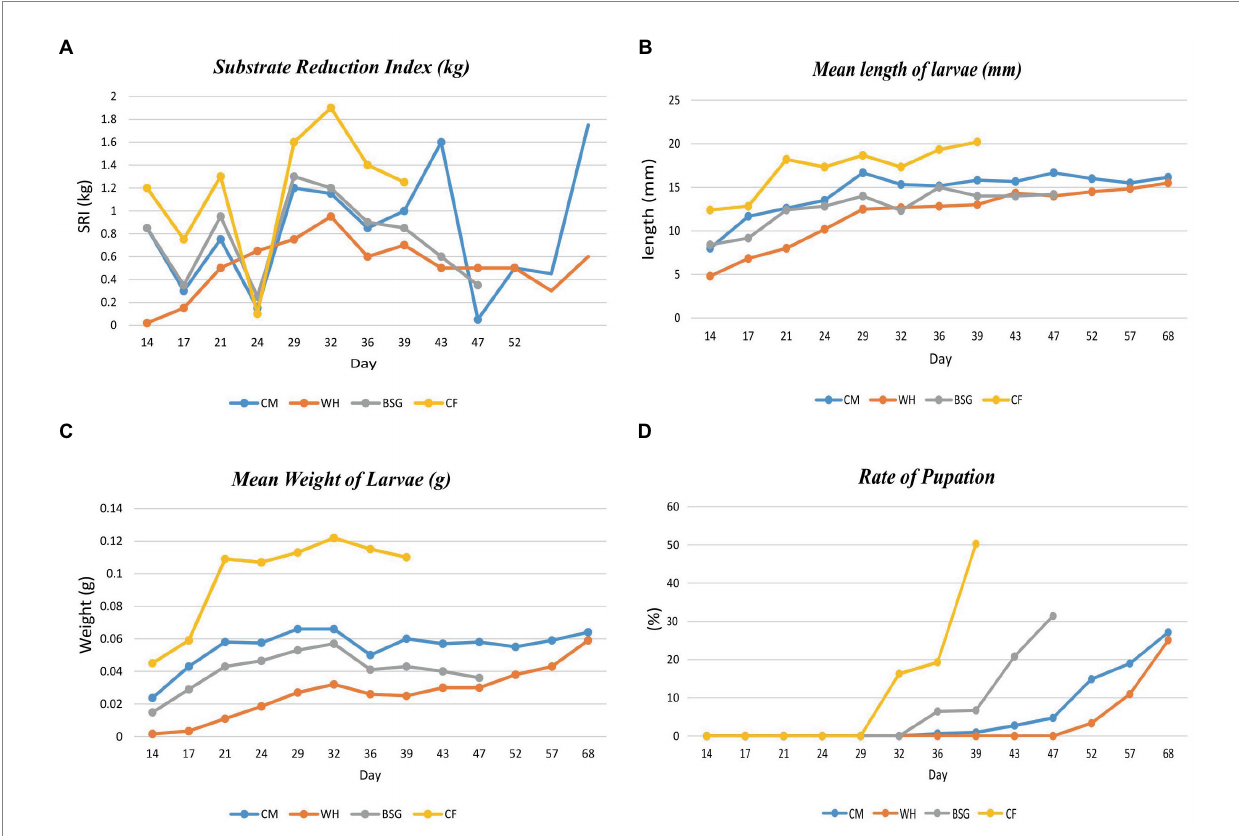
FIGURE 2 Parameter collection during BSFL rearing. Substrate reduction index (A) and growth parameters [Length (B) , weight gain (C) , and the rate of pupation (D) ] of BSFL reared on various